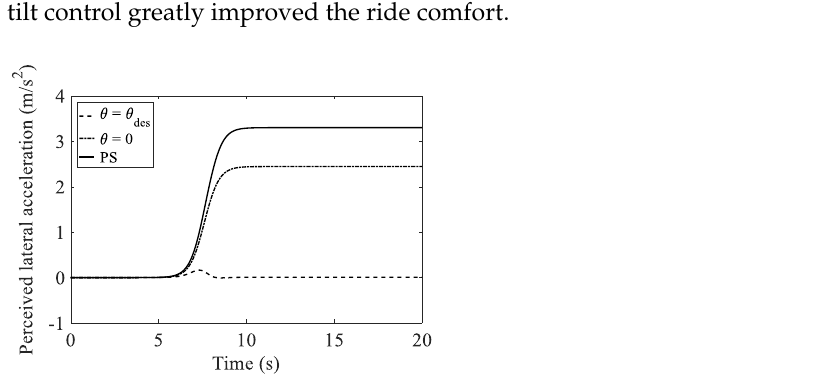
Figure 6. Roll angle of the vehicle body.